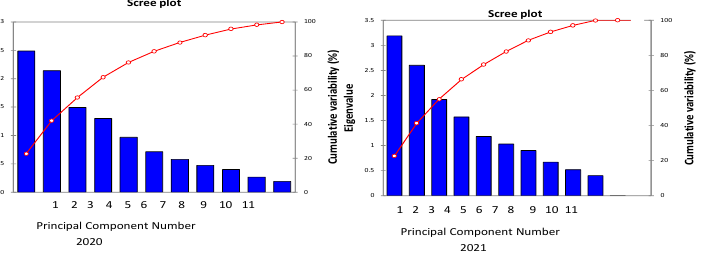
Figure 3. Scree plot of principal component analysis rice hybrids between their eigen values, number of principal component and accumulative variability% under adaptability trials 2020–2021.